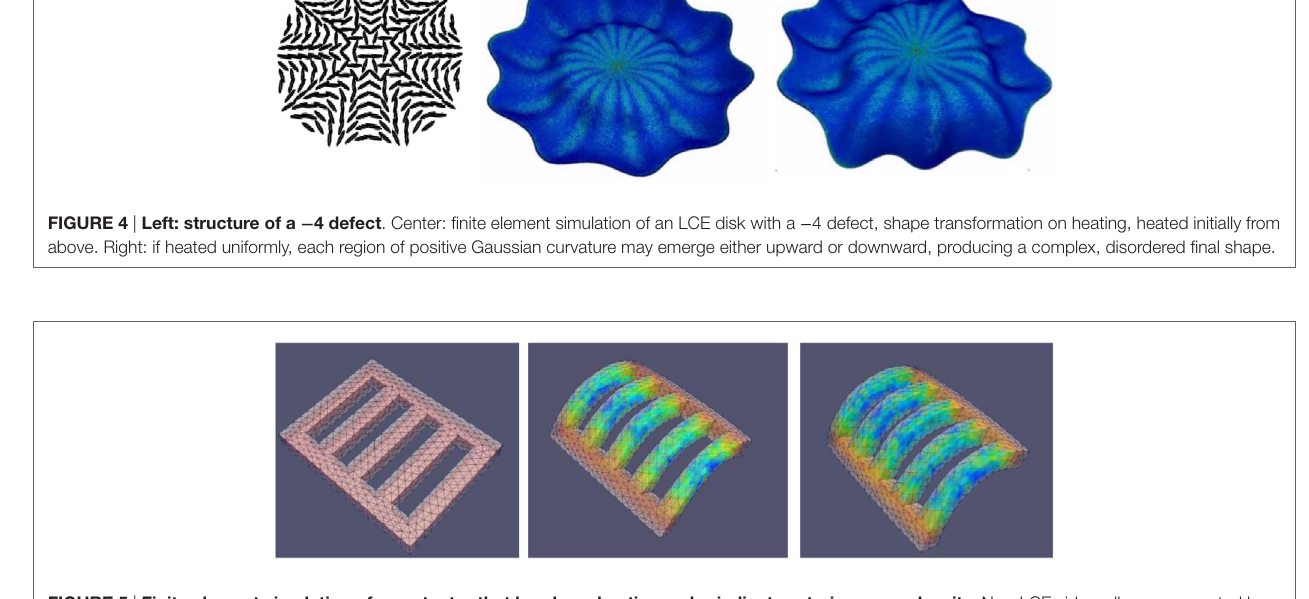
FigUre 5 | Finite element simulation of an actuator that bends on heating; color indicates strain energy density . Non-LCE side walls are connected by short LCE beams, each of which has homeotropic director orientation along the top surface and planar orientation at the bottom surface with a smooth gradient in between. Open spaces along the bending zone accommodate transverse strain of the LCE beams without lateral shrinkage or buckling of the straight side walls.